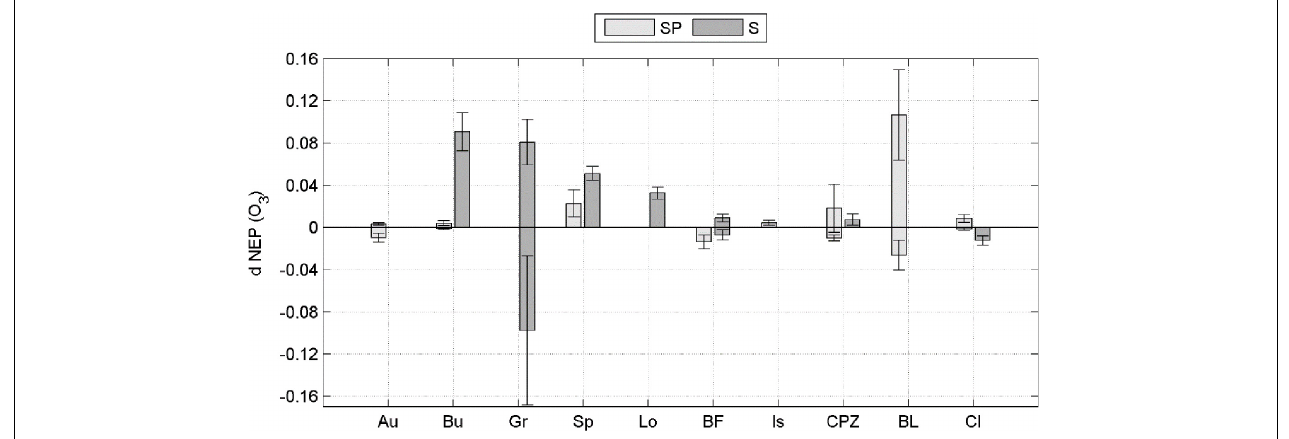
FIGURE 1 | Positive and negative sensitivity of the NEP response to FO 3st or FO 3CUM (d NEP (O 3 ), presented separately for Spring (SP) and Summer (S) seasons. Bars represent standard